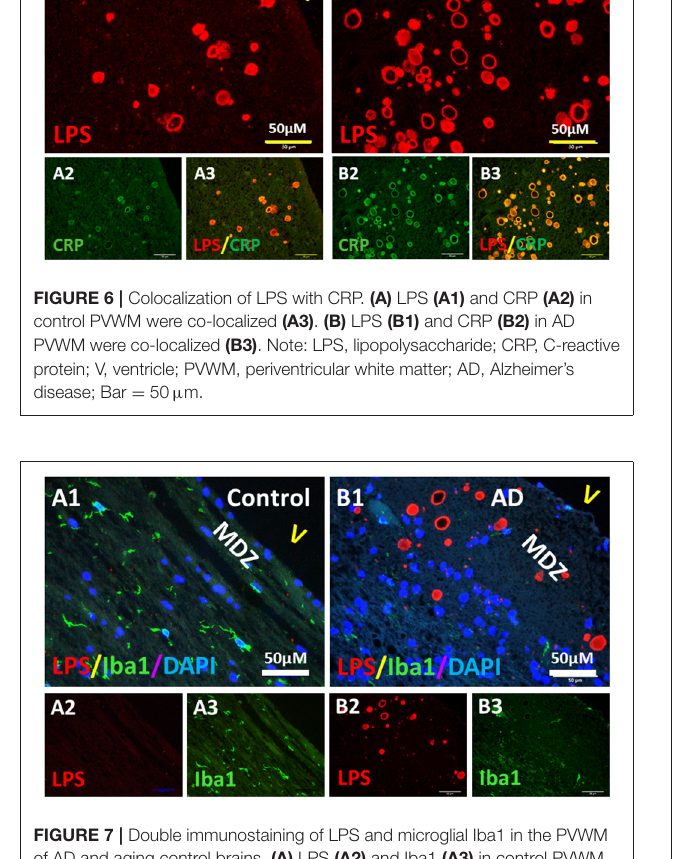
FIGURE 8 | Localization of GFAP and LPS in the vesicles in AD and aging WM. (A) GFAP was intensely stained in the control PVWM myelin deficient zone, which forms a GFAP reactive layer immediately beneath the ependymal lining (A1,A3) . DAPI stained all nuclei in the section, including the ependymal cells (A2,A3) . (B) GFAP was intensely stained in the AD PVWM myelin deficient zone, which forms a GFAP reactive layer immediately beneath the ependymal cells (B1,B3) . The GFAP stained layer was thicker where ependymal cells were partially lost ( B1–B3 , red arrow) compared to areas where ependymal cells were intact ( B1–B3 ; yellow arrow). DAPI staining showed loss of ependymal cells in some areas ( B2,B3 red arrow). (C) In control deep white matter (Con DWM), scattered astrocytes were observed (C1) a few of which stained for LPS (C2,C3) . (D) In Alzheimer’s Disease deep white matter (AD DWM) scattered astrocytes (D1) were also observed, many of which stained for LPS ( D1–D3 , arrow). (E) In control periventricular white matter (Con PVWM) scattered astrocytes were observed (E1) some of which were stained for LPS ( E2,E3 , arrow). (F) In Alzheimer’s Disease periventricular white matter (AD PVWM) there was dense GFAP staining throughout the myelin deficient zone (F1) . LPS staining showed discrete vesicles in this zone (F2) , the margins of which appeared to co-localize with or were immediately adjacent to GFAP positive astrocytic processes (F3) . Note: LPS, lipopolysaccharide; V, ventricle; WM, white matter; PVWM, periventricular white matter; DAPI, nuclear stain; DWM, deep white matter; AD, Alzheimer’s disease; Bar = 100 µ m in (A,B) ; Bar = 50 µ m in (C–F)